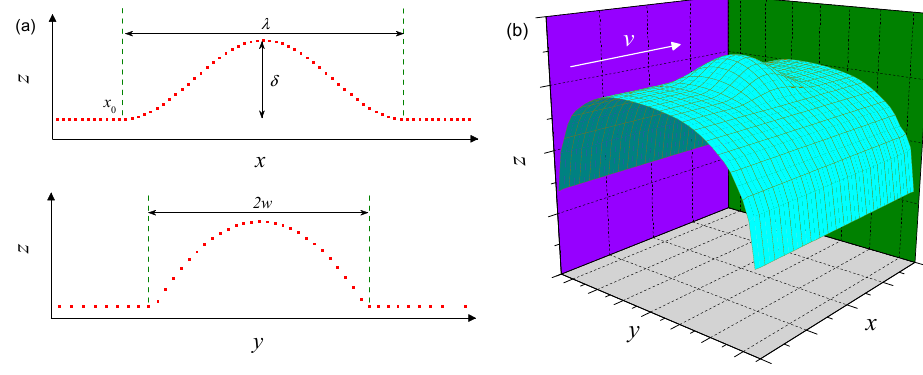
Figure 8. Simulated rail weld geometry in ( a ) 2D and ( b ) 3D.